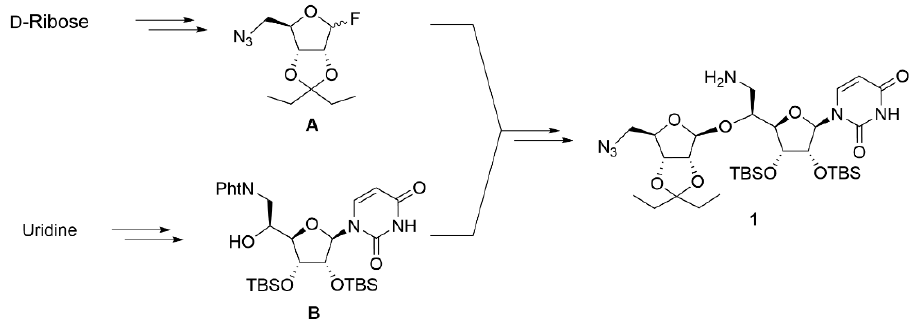
Figure 3. Synthetic route towards the common intermediate 1 .